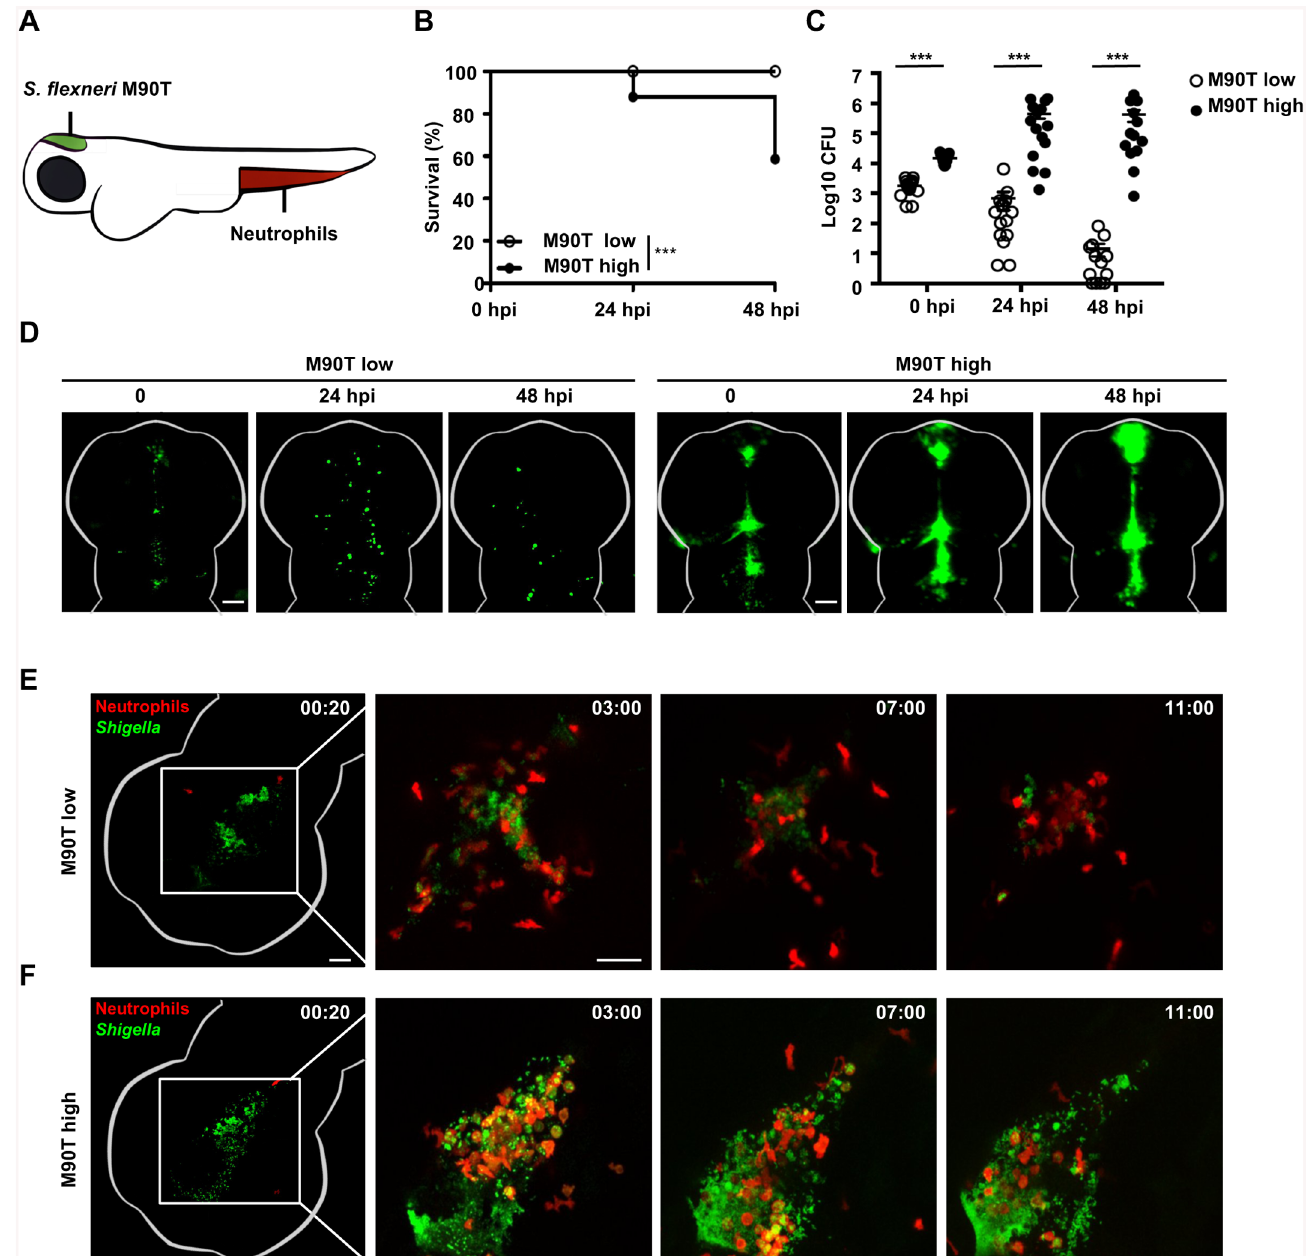
Fig 1. S . flexneri infection of the zebrafish hindbrain ventricle. A. Cartoonof zebrafishlarva (3 dpf) showinglocalization of neutrophilsprior to infection (red) and the site of S . flexneri M90T (green) injectionin the HBV. B. Survival curves of larvae infected with a low ( (cid:20) 3 x 10 3 CFU) or high ( (cid:21) 1 x 10 4 CFU) dose of S . flexneri M90T. Pooleddata from 5 independent experiments per inoculumclass using at least 15 larvae per experiment. Significancetesting performed by Log Rank test. *** , P < 0.001.C. Enumerationof bacteria at 0, 24, or 48 hpi from survivinglarvae infected with a low (open circles) or high (closedcircles) dose of S . flexneri M90T. Pooleddata from 5 independentexperiments per inoculumclass using up to 3 larvae per treatment. Circles represent individuallarvae, and only larvae havingsurvived the infection (thus far) includedhere (i.e., dead larvaenot homogenised for counts). Mean ± SEM also shown (horizontal bars). Significance testing performed by Student’s t test. *** , P < 0.001.D. Representative images of larvaeinfected in the HBV with low or high dose of GFP- S . flexneri M90T. For each dose, the same larva was imagedat 0, 24, and 48 hpi using a fluorescent stereomicroscope. Scale bars, 100 μ m. E-F. Representative frames extracted from in vivo time-lapse confocal imagingof lyz :dsRedlarvae (3 dpf, red neutrophils) injected in the HBV with a (E) low dose or (F) high dose of GFP- S . flexneri M90T. First frame 20 mpi, followedby frames at 3, 7, and 11 hpi. Maximum intensity Z-projectionimages (2 μ m serialoptical sections) are shown. Scale bars, 50 μ m. See also S2 and S3 Videos.